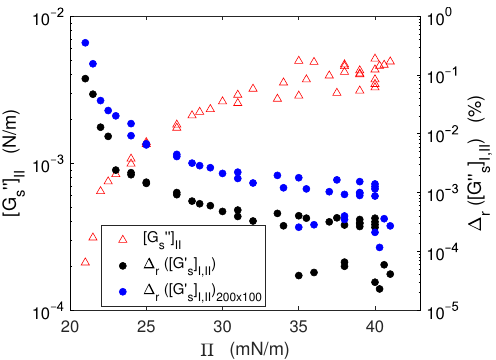
Figure 13. Loss modulus, [ G (cid:48)(cid:48) s ] II , (red triangles) and relative difference, ∆ r ([ G (cid:48)(cid:48) s ] I , II ) , between results using PV-I and PV-II (black dots) of a PDA Langmuir monolayer, as a function of the interfacial pressure Π . The relative differences ∆ r ([ G (cid:48)(cid:48) s ] I , II ) are shown for two different spatial resolution meshes: 1000 × 500 nodes (black dots) and 200 × 100 nodes (blue